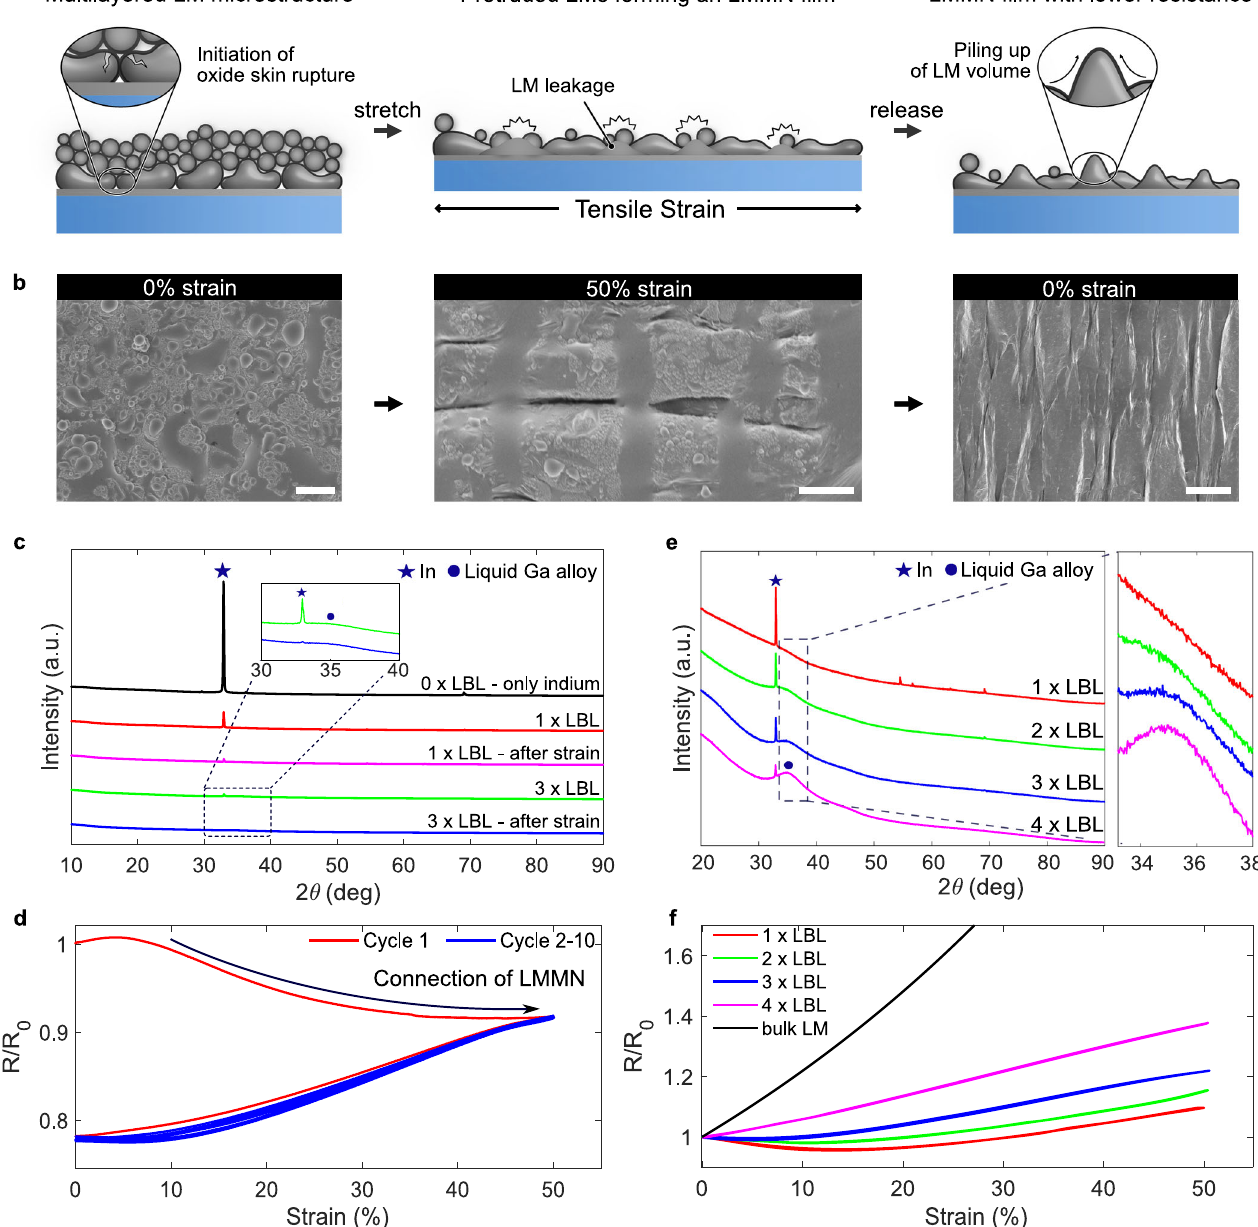
Fig. 3 Connection of LMMN. a Schematic representation of a transition of a multilayered LM microstructure to an LMMN fi lm. b Corresponding SEM Images of the transition of a multilayered LM microstructure with four gallium layers (4 × LBL) before stretch (scale bar: 2 µm), stretched up to 50% strain (scale bar: 2 µm), and released from the strain (scale bar: 10 µm) from left to right. c XRD patterns of multilayered LM microstructures (1 × LBL and 3 × LBL) before and after strain. The sharp peak corresponding to the indium (101) plane (ICDD PDF Card 3065-929) decreases after strain experience. The wide peak around 35° corresponds to liquid gallium alloy. d Relative resistance response of the multilayered LM microstructure (3 × LBL) to the fi rst ten cycles of 50% tensile strain. e XRD patterns of the LMMN fi lms with different numbers of gallium layers (1 – 4 × LBL). Note that the fi lms did not experience any strain. f Relative resistance response of LMMN fi lms with different numbers of gallium layers (1 – 4 × LBL). The fi lms experienced 50% strain before the measurement. The response of bulk LM (black curve) was calculated under the assumption of constant electrical